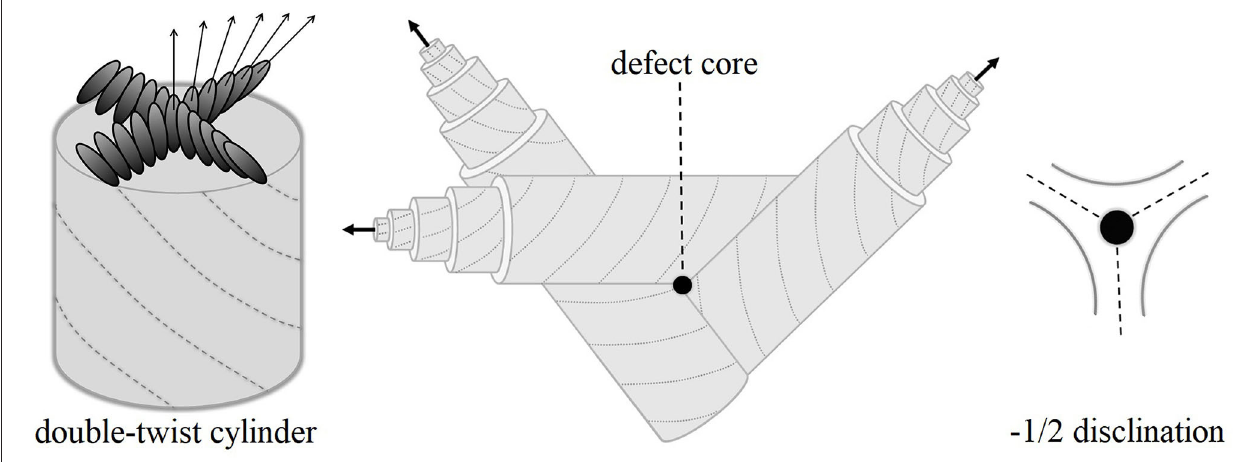
FIGURE 1 | At the left-hand side, the molecular orientation is shown along the cross section of a double-twist cylinder of the blue phase structure. The director (marked by arrows) is parallel to the cylinder axis in the center and gradually changes toward ± 45 ◦ at the periphery. Defects appear in the volume between double-twist cylinders, as seen in the center. The topology enforces − 1/2 disclinations as shown at the right-hand